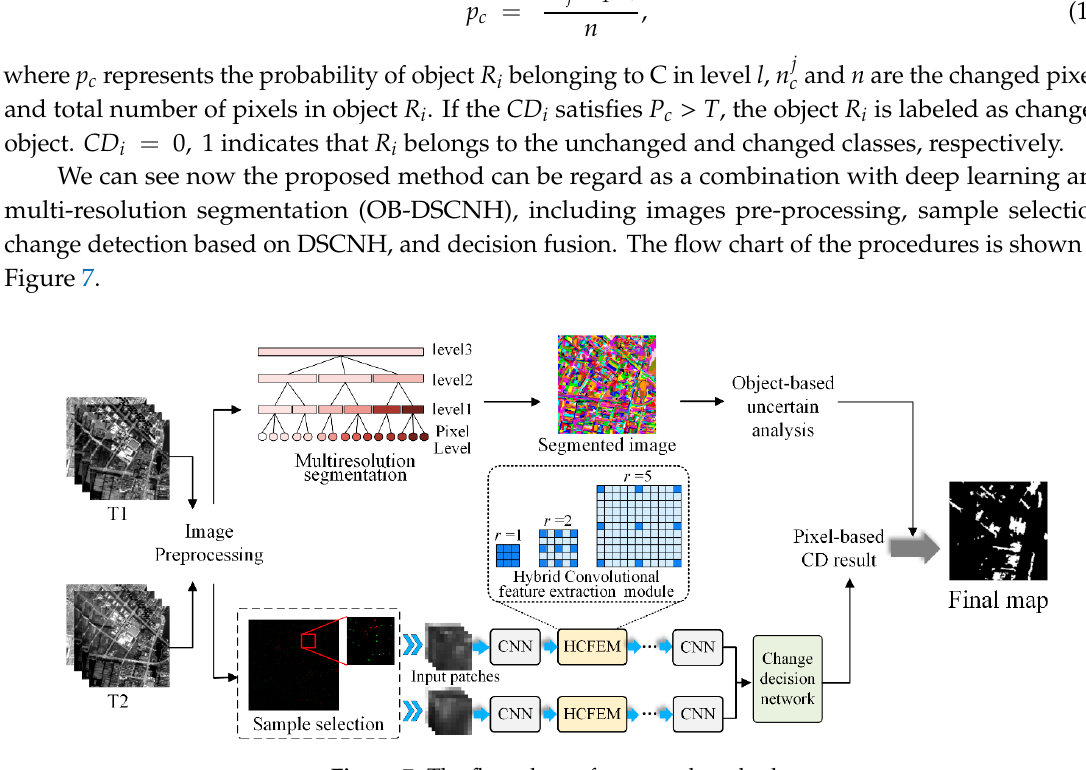
Figure 7. The flow chart of proposed method.